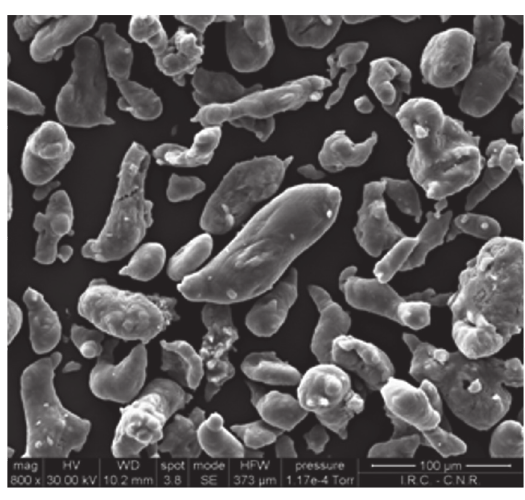
Figure 4: SEM micrograph of the powders used for the cold spray repairing.